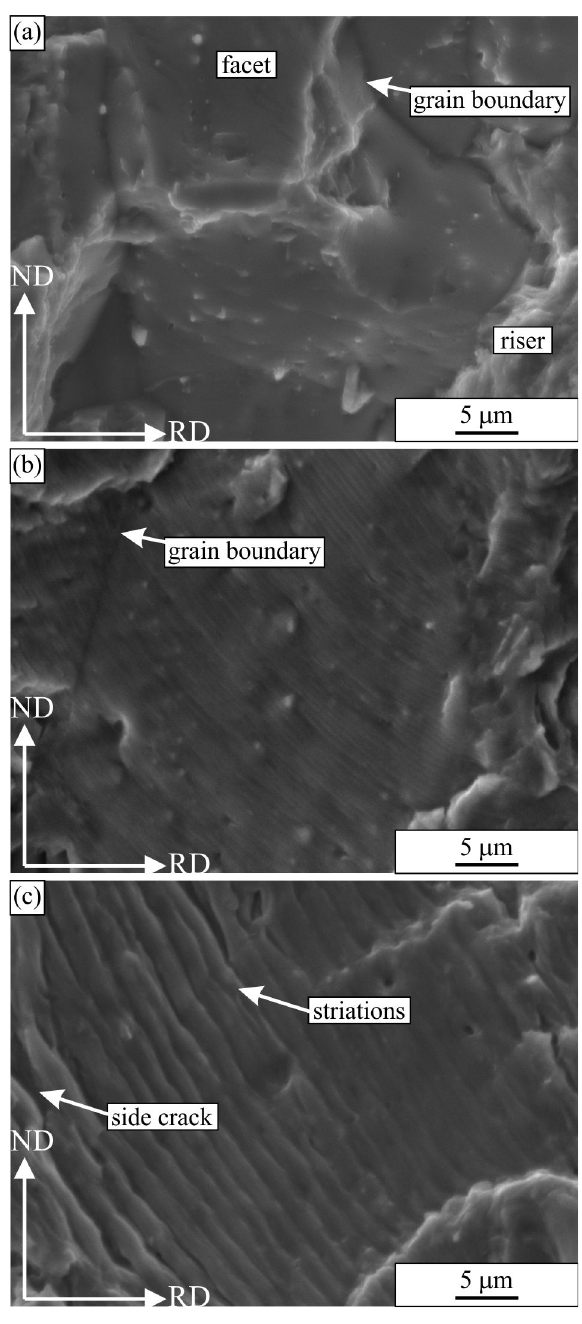
Figure 12. Secondary electron micrographs of the fractured surfaces of the fatigue sample PSV 14 (765,121 cycles to failure): ( a ) 0.7 mm from the fatigue crack initiation (Stage Regime A), ( b ) 1.4 mm from the fatigue crack initiation (start of Regime B), ( c ) 3.5 mm from the fatigue crack initiation (near the end of Regime B).